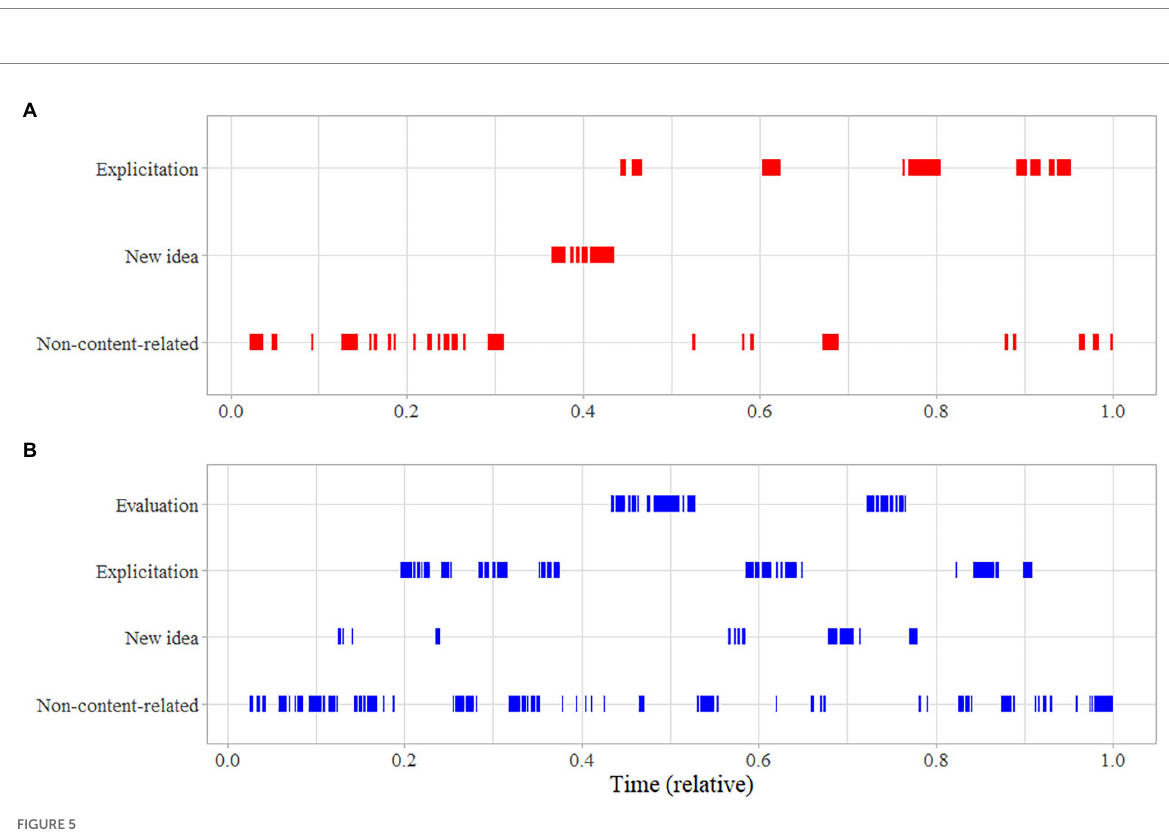
1S (Sharing student): Mm. Yes … And outside then … But does [the electric field] change if …